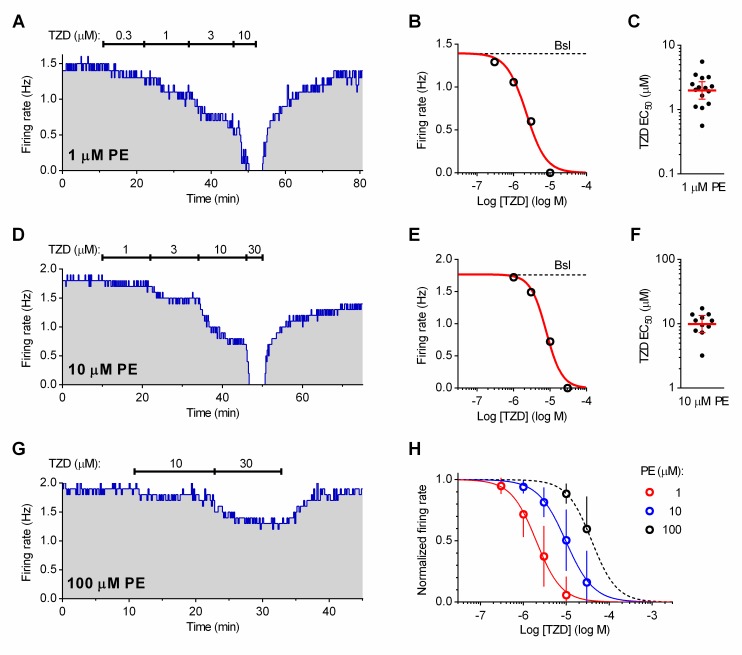
Block of 5-HT1A receptors by Way-100635 uncovers the α1-adrenoceptor- dependent effect of trazodone.(A) Representative experiment showing the effect of trazodone (TZD) on neuron firing facilitated by 1 μM phenylephrine (PE) in the presence of Way-100635 (20 nM). (B) DRC resulting from the experiment shown in (A). Red line is the best least-squares fit to the logistic equation. (C) Scatter plot of the individual EC50 values calculated from fifteen similar experiments. (D) Representative experiment showing the effect of trazodone on neuron firing facilitated by 10 μM PE (E) DRC resulting from the experiment shown in (D). Red line is the best least-squares fit to the logistic equation. Note that 30 μM trazodone is required to silence the neuron. (F) Scatter plot of the individual EC50 values calculated from eleven experiments. (G) Representative recording from a set of experiments (n = 9) in which trazodone 10 μM and 30 μM was applied in the presence of 100 μM PE. In (B) and (E), dotted line indicates the baseline (Bsl) firing rate before application of trazodone. In (C) and (F), red line and error bars indicate the geometric mean and 95% C.I. (H) Average DRCs of trazodone effect obtained from the experiments in PE 1–100 μM. Symbols and error bars correspond to the mean values± SD obtained for each concentration in the corresponding set of experiments. Red line is the best least-squares fit to the logistic equation. Data are normalized on average baseline firing rates recorded before trazodone application. The baseline firing rates of neurons recorded in the three groups were (Hz, mean ± SD): 1.840 ± 0.5444 in PE 1μM (n = 15), 1.766 ± 0.4040 in PE 10μM (n = 11) and 1.970 ± 0.5559 in PE 100 μM (n = 9). These values were not significantly different (F(2.32) = 0.4046; p = 0.6706; One-Way ANOVA).